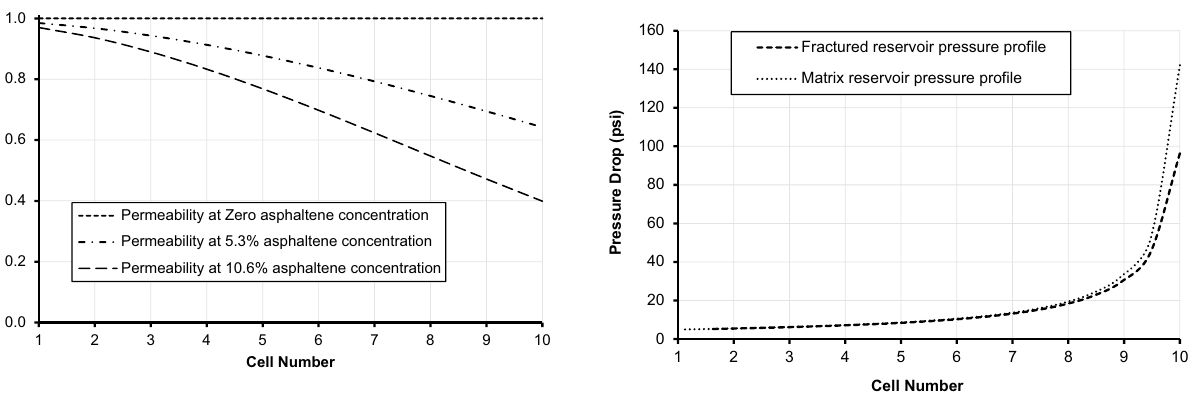
Fig. 10 Pressure drop profile for fractured and non-fractured (matrix)